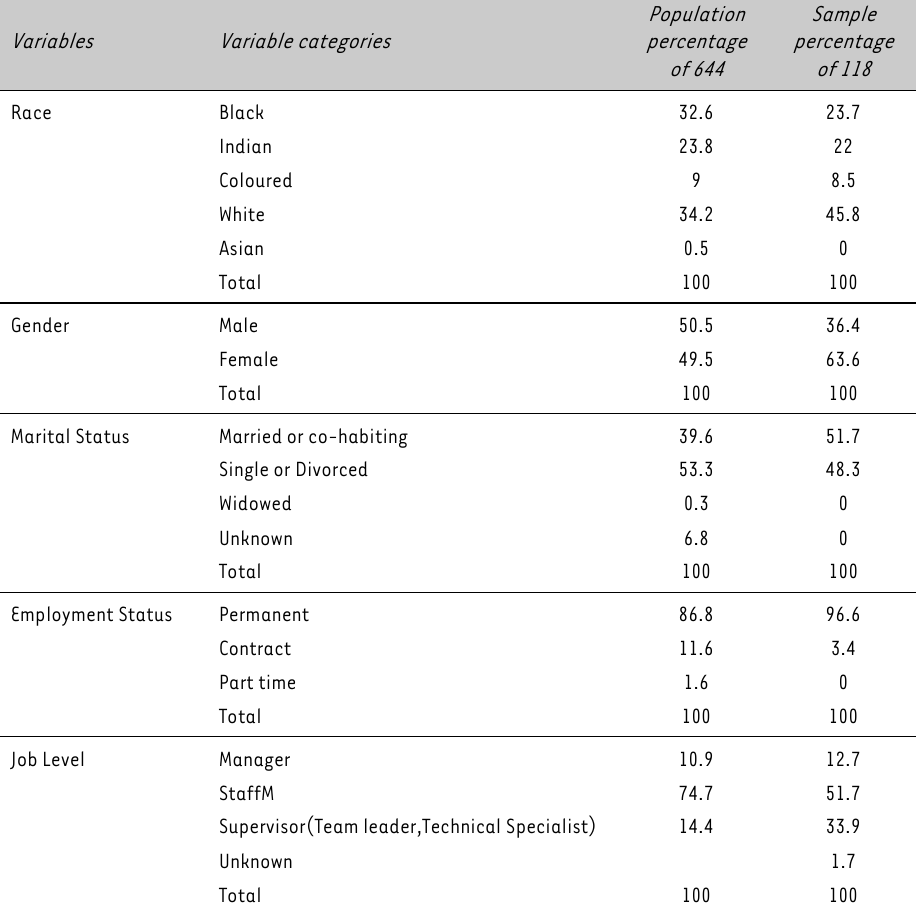
TABLE 2: Comparison of background information of population and